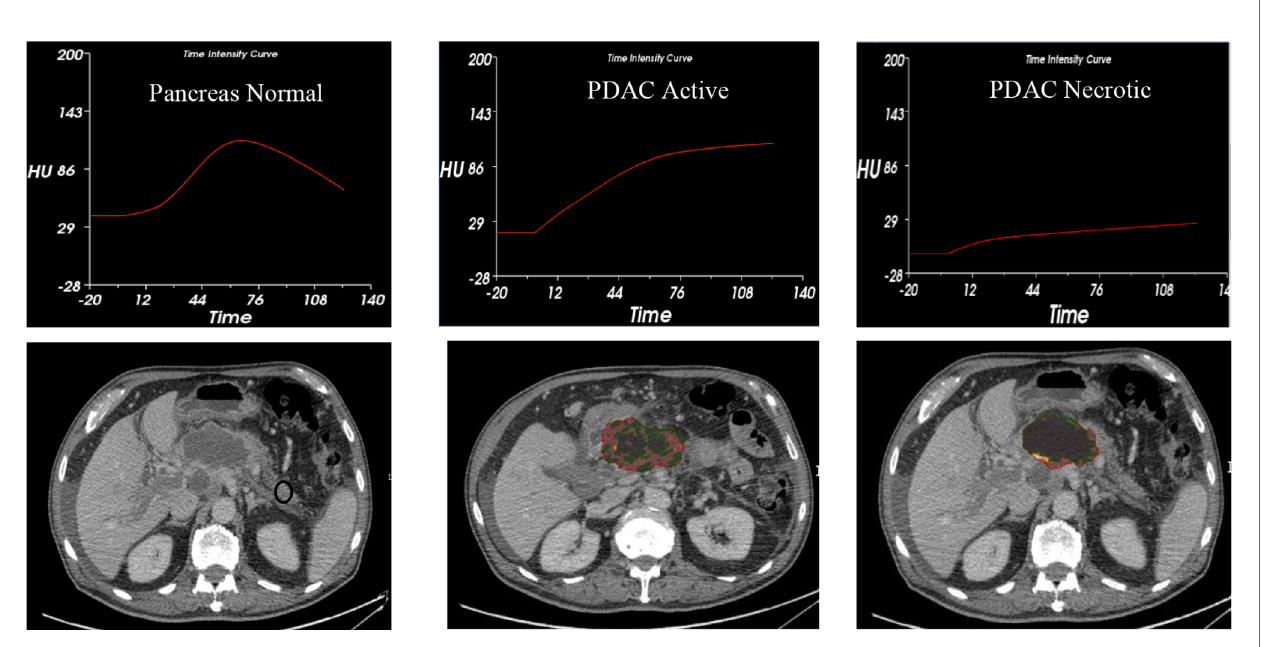
FIGURE 5 | Time Intensity/Density